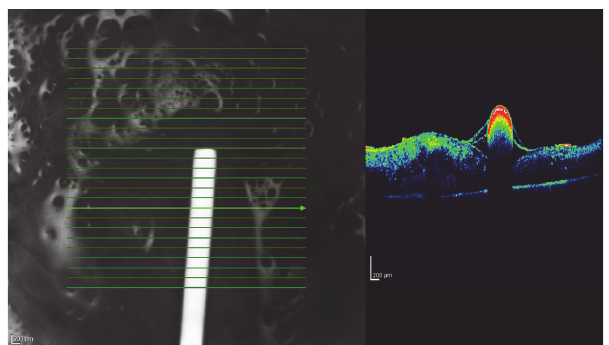
Figure 1: Optical coherence tomography analysis shows hyper- reflectance of the intravitreal dexamethasone implant at the fovea with optical